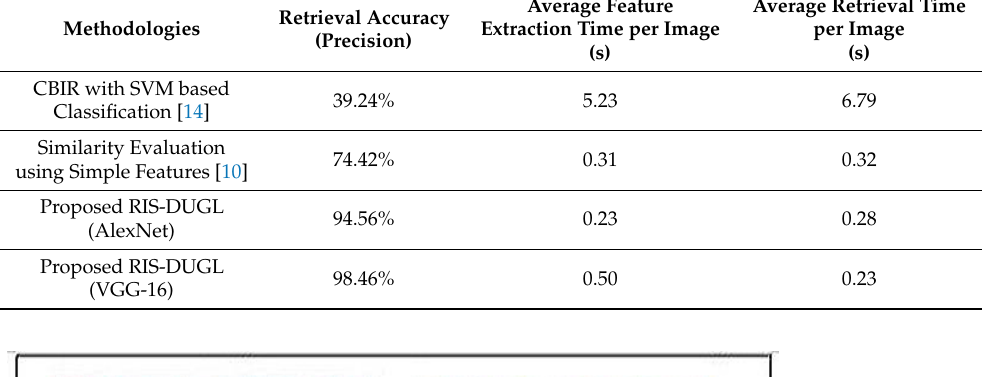
Table 2. Comparison of time and accuracy of the proposed model with conventional methods.